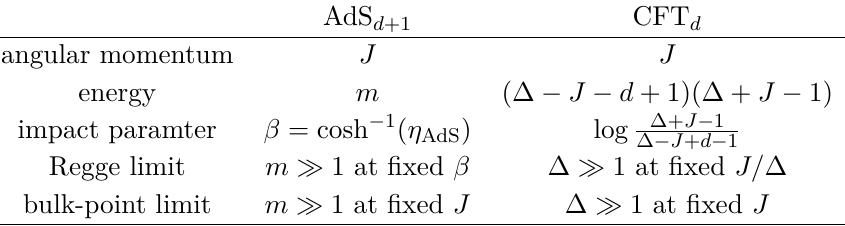
Table 3 . Dictionary between AdS and CFT quantum